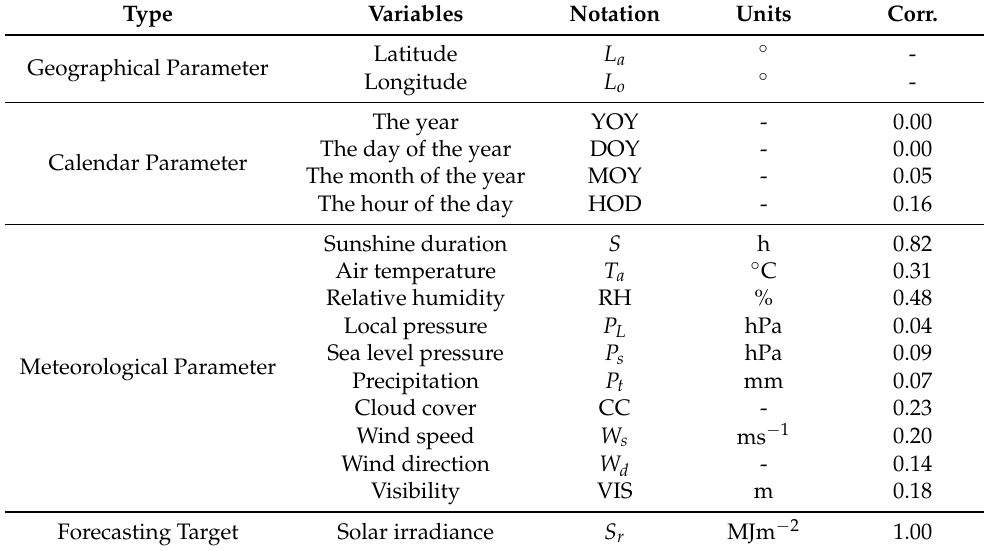
Table 1. Meteorological variables associated with ASOS data for solar irradiance prediction. The fourth column presents absolute values of Pearson correlation coefficients of historical solar irradiance (01/2017–12/2019) with other meteorological variables. Type Variables Notation Units